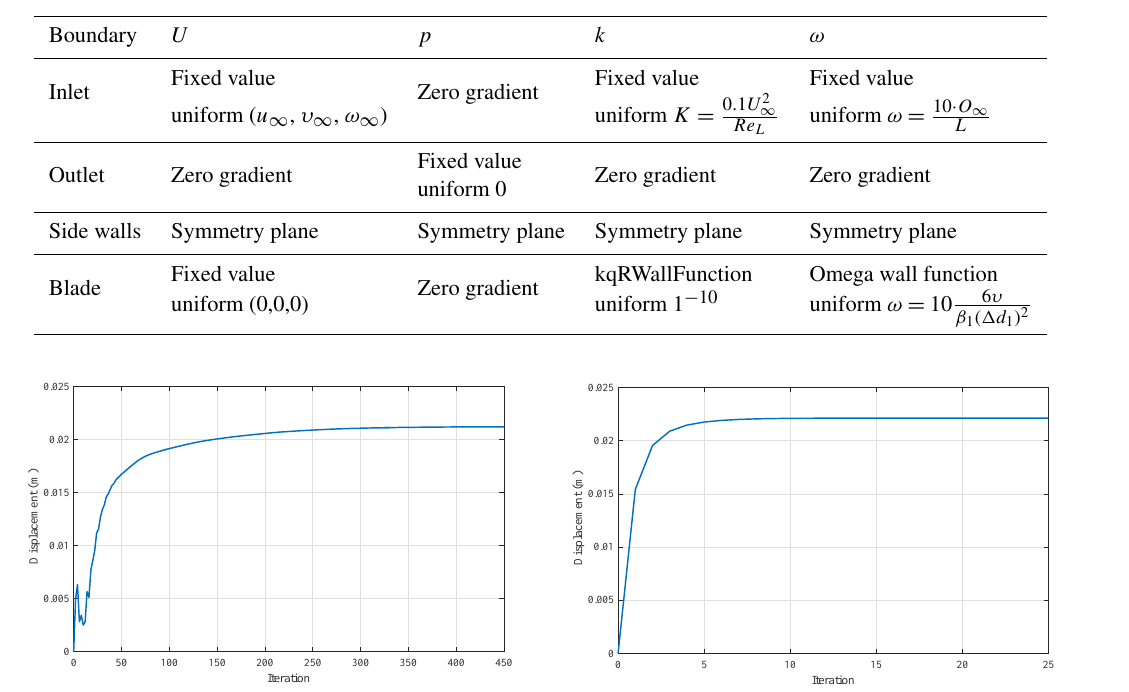
Table 4. Boundary conditions for computational fluid dynamics (CFD) simulations.